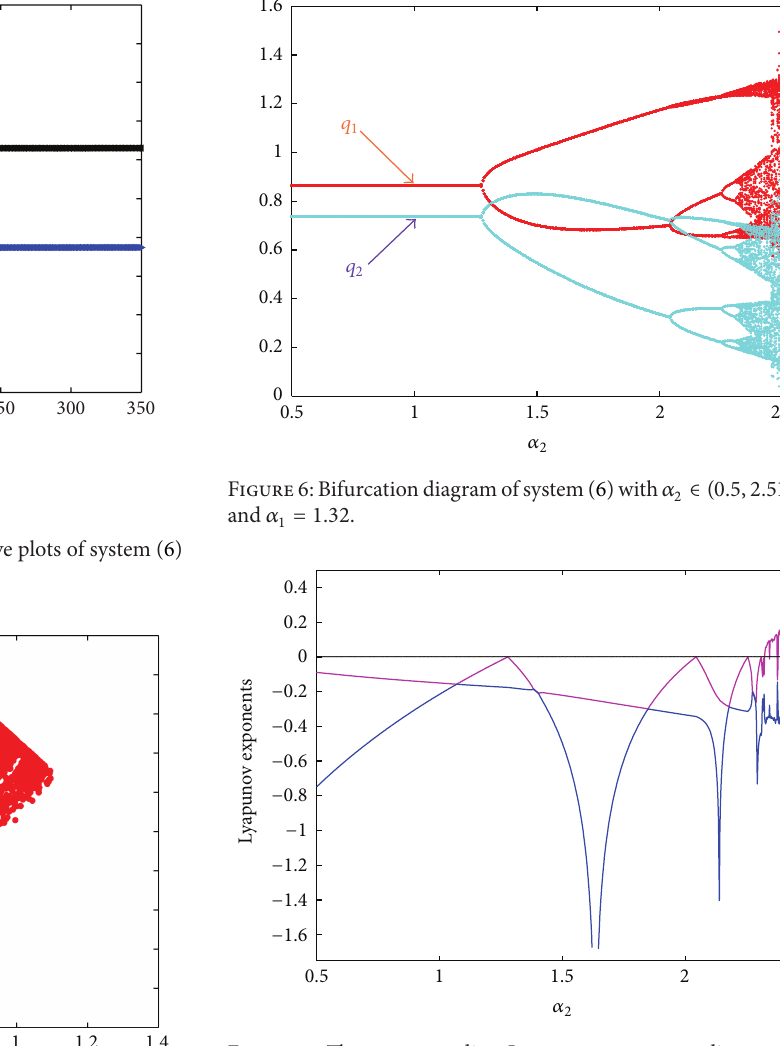
For 𝜃 ∈ (0.659201, 0.782679] , the output 𝑞 2 = 0 , but the output 𝑞 1 has 2-cycle output orbits as shown in Figure 14.